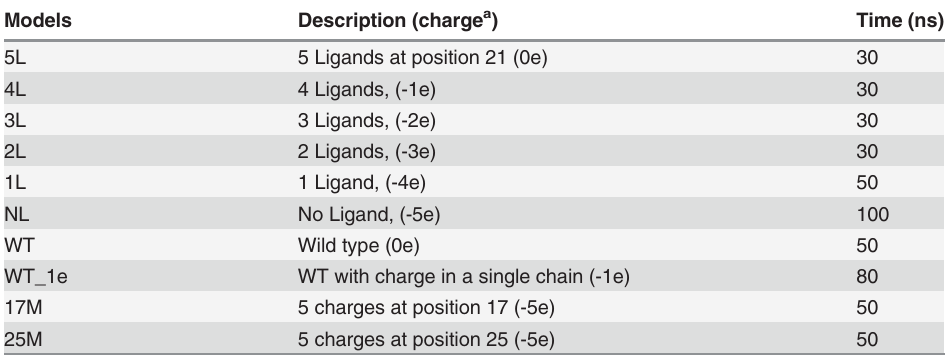
Table 1. Summary and description of the simulations.